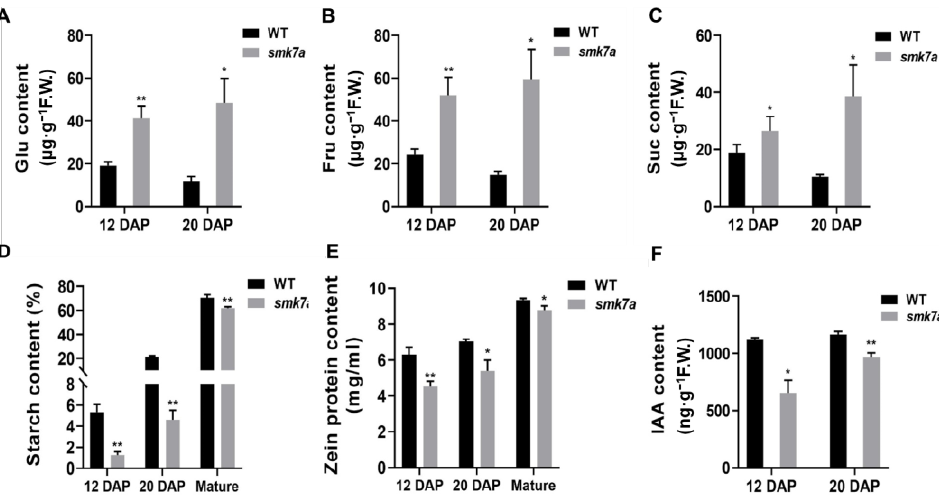
Figure 3. Comparison of biochemical values of kernels from the WT and smk7a mutant. ( A – C ) Comparison of the soluble sugar contents of the WT and smk7a at 12 and 20 DAP. Glc, glucose, Fru, fructose, Suc, sucrose. ( D ) Starch contents of the WT and smk7a at 12 and 20 DAP and in the mature stage. ( E ) Zein protein contents of the WT and smk7a at 12 and 20 DAP and in the mature stage. ( F ) Free IAA contents of the WT and smk7a at 12 and 20 DAP. All of the values are the means of the three replicates ± SD. ** denotes statistical significance at p < 0.01, and * denotes statistical signifi- cance at p < 0.05, according to the t-test when compared with the values of the WT. 2.3. Transcriptome Comparison of Developing Kernels from WT and smk7a To reveal the gene expression changes between the WT and the smk7a mutant, we conducted RNA sequencing (RNA-seq) using the kernels collected at 12 and 20 DAP. On average, 48.2 million clean reads were obtained for each sample, and 89.2 – 94.9% of the reads were uniquely mapped to the maize B73 reference genome (Table S1). With a threshold fold change of >2 and an adjusted p value of <0.05, a total of 3,405 and 2,747 differentially expressed genes (DEGs) were identified between smk7a and WT for the 12 and 20 DAP kernels, respectively. Further classification of the DEGs revealed that there were 1,522 downregulated genes and 1,883 upregulated genes at 12 DAP, and there were 1,124 downregulated genes and 1,623 upregulated genes at 20 DAP (Tables S2 – S3). Since the BETL development was impaired in smk7a , we checked the expression levels of the BETL-specific genes. At 12 DAP, six genes were significantly downregulated in smk7a , namely, BETL3 , BETL4 , BETL9 , TCRR1 , TCRR2, and SWEET4C , while only the SWEET4C gene was significantly downregulated at 20 DAP. The expression levels of BETL4 , BETL9 , TCRR1 , and SWEET4C in s mk7a and WT were further verified using the quantitative re- al-time polymerase chain reaction (qRT-PCR) method (Figure S3A). The reduced expres- sion of the BETL-specific genes in smk7a validated the development defects of the BETL cells. To associate functions with the DEGs, we performed gene ontology (GO) enrich- ment analysis. The 20 most significantly ( p < 0.05) enriched GO terms in the biological process, molecular function, and cellular component categories are presented in Figure S3. At 12 DAP, the downregulated genes were mainly enriched in the BP term “ starch biosynthetic process” , the MF term “nutrient reservoir activity”, and the CC terms “chloroplast and amyloplast” , while the upregulated genes were mainly enriched in the BP terms “cell differentiation” , “lipid catabolic process” , and “hydrogen peroxide cata- bolic processes” , the MF term “heme binding”, and the CC term “extracellular region” (Figure S2A). At 20 DAP, the downregulated genes were significantly enriched in the BP term “ secondary metabolite bi osynthetic process” , the MF term “ nutrient reservoir ac- tivity”, and the CC term “extracellular region” , while the upregulated genes were mainly enriched in the BP terms “defense response” and “ hydrogen peroxide catabolic process-